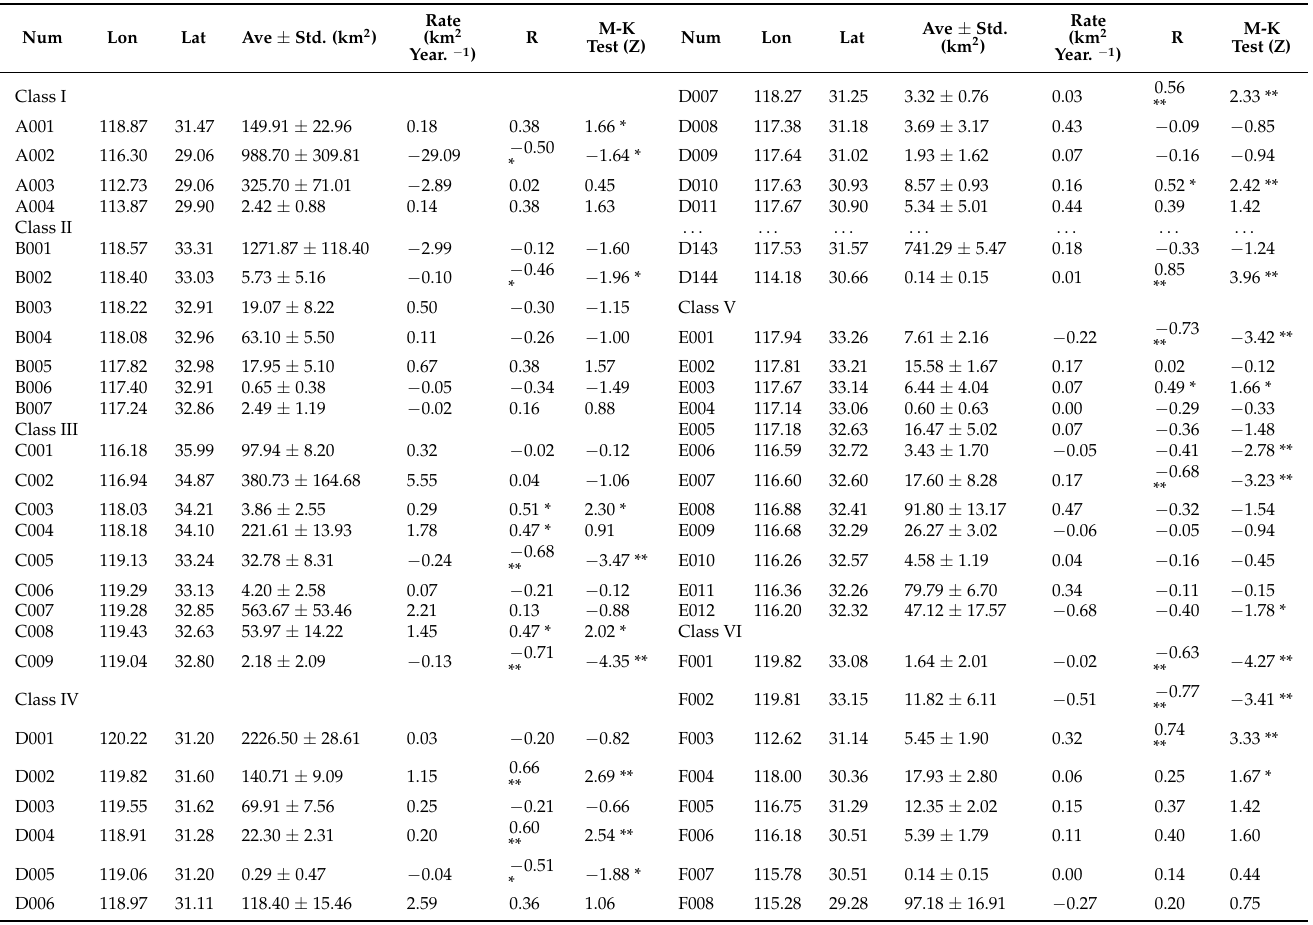
Table 3. Summary of information (number and location) and changes in lake annual area (average area and standard deviation during 2000–2020). Statistically significant correlations and contributions are annotated with * p < 0.05 and ** p < 0.01. The full table is shown in Table